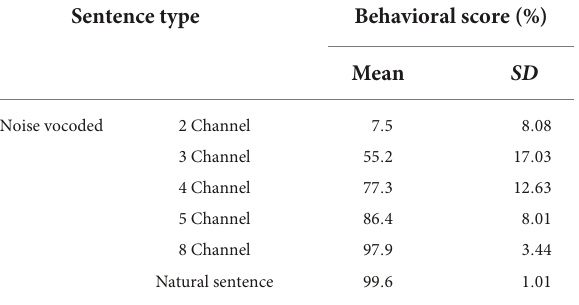
TABLE 2 Results of behavioral speech intelligibility scores with natural and noise vocoded sentences.